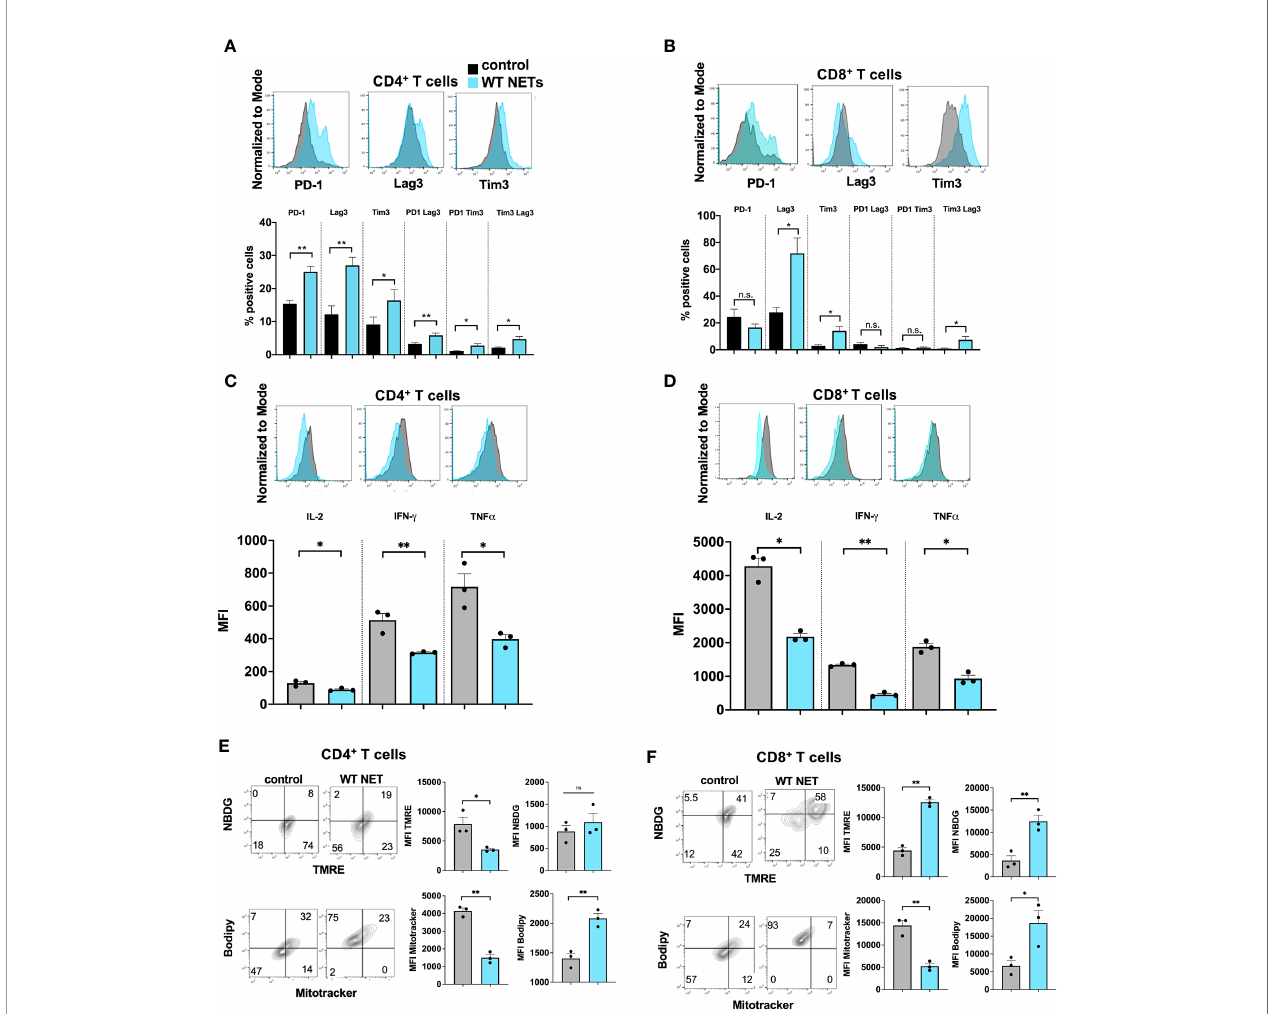
FIGURE 4 | NETs cause phenotypic, metabolic and functional T cell exhaustion in vitro. Splenic CD4 + T cells were pretreated with CD3/28 beads and then cultured for 72h in the presence of isolated WT NETs. (A, B) Markers for T cell exhaustion analyzed by fl ow cytometry were signi fi cantly upregulated on T cells in the presence of WT NETs. (C, D) T cell intracellular cytokines were analyzed by fl ow cytometry following fi xation and permeabilization. T cells in the presence of WT NETs expressed signi fi cantly lower levels of intracellular cytokines. (E, F) Similarly, following culture with WT NETs, T cells were stained with metabolic markers, showing decreased metabolic activity in the presence of WT NETs. Bar graphs represent mean +/- SEM of three independent experiments, performed in duplicates or triplicates. *p < 0.05, **p <